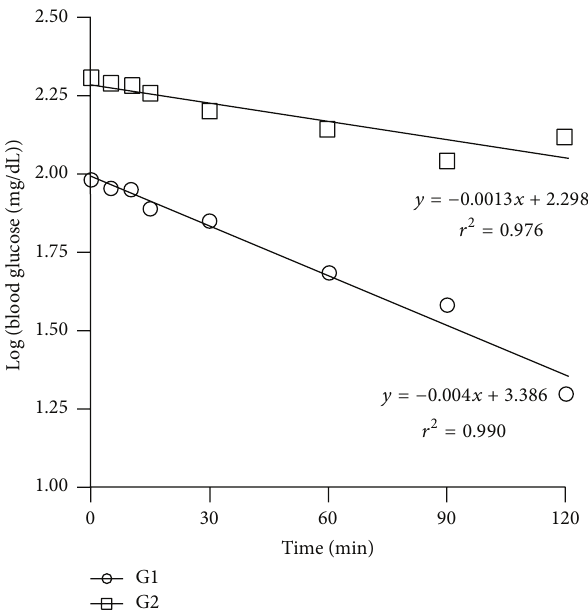
Figure 4: Determination of insulin tolerance (K-ITT) in normal and nicotinamide, STZ diabetic rats; first-order rate constant for the disappearance rate of glucose from plasma (K-ITT) upon insulin treatment (4IU/kg, i.p.) was estimated from the slope of the regression line of the logarithmic plot of blood glucose (in mg/dL) against time. Slope is negative because blood glucose decreases with time after insulin. (G1: normal rats and G2: diabetes induced rats). The figure does not show the plots of all treated groups because values are close to each other and